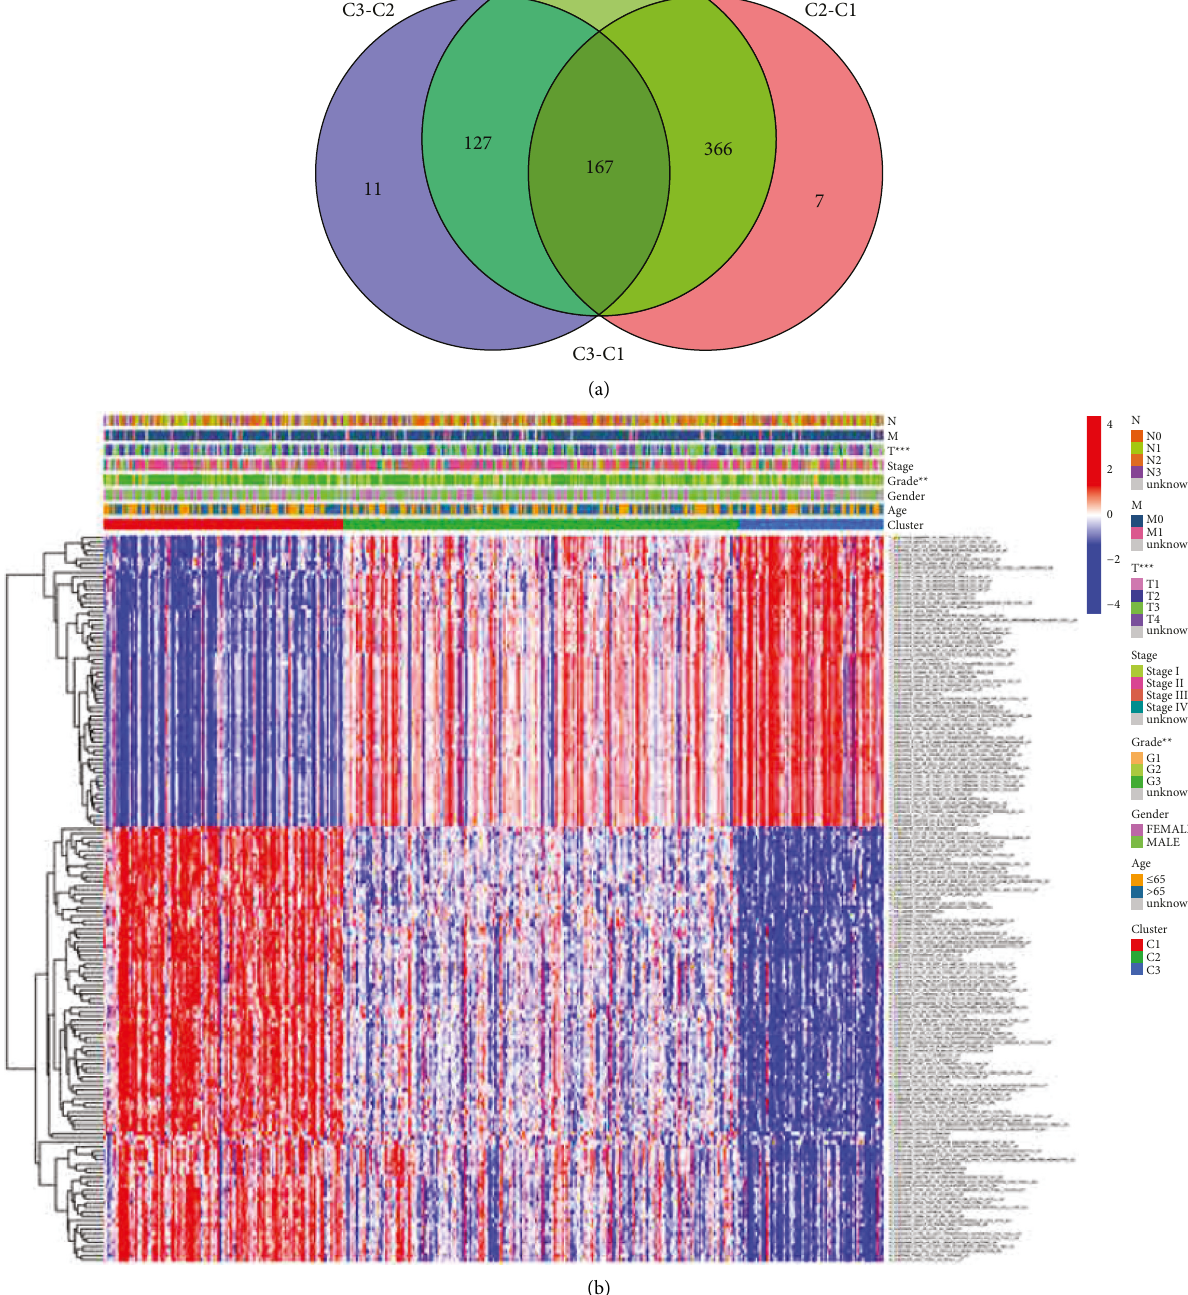
Figure 4: Generation of core gene sets among three clusters. (a) Veen map was drawn and identification of 167 gene sets by intersecting of three clusters. (b) Correlation between core gene sets and clinical